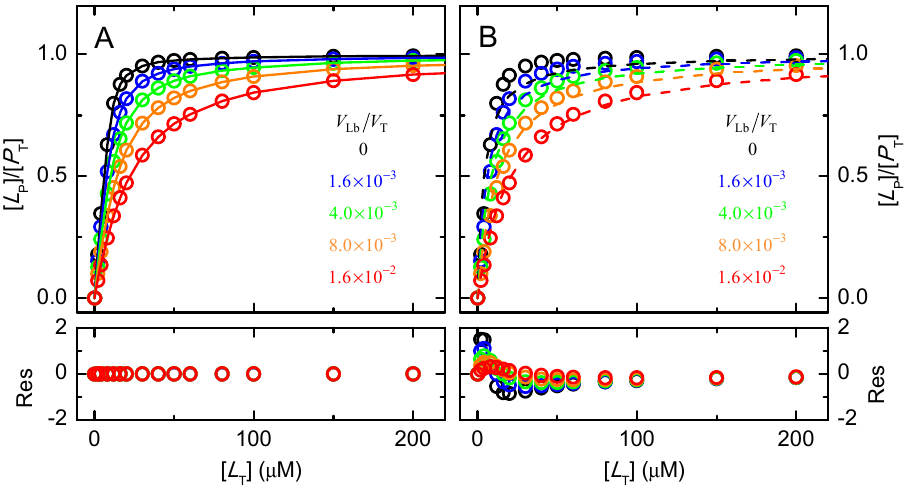
Figure 2. Dependence of the protein saturation with ligand ([ L P ]/[ P T ]) with the total ligand concen- tration, for a protein soluble in the aqueous phase with M W = 50 kDa and a total concentration [ P T ] L K = 10 3 ; in the absence of a =10 μ M (corresponding to V P = 4.2 × 10 − 4 V T , W L eq K = 10 6 M − 1 , and W P Lb lipid bilayer and in the presence of increasing lipid concentrations as indicated in the plots. The lines are the best fits neglecting the sequestration of the ligand by the lipid bilayer, considering either the concentration of ligand in the aqueous medium, Equation (6) (plot ( A )) or the total ligand concen- tration, Equation (7) (plot ( B )). The residuals of the best fit are shown in the bottom plots. As expected, the presence of the lipid bilayer leads to the sequestration of ligand and decreases the amount of ligand in the aqueous medium (see Appendix B, Figure A1) and associated with the protein. If protein saturation is described with a model that neglects ligand association with the lipid bilayer, Equation (6), the binding affinity obtained is ap- parent (